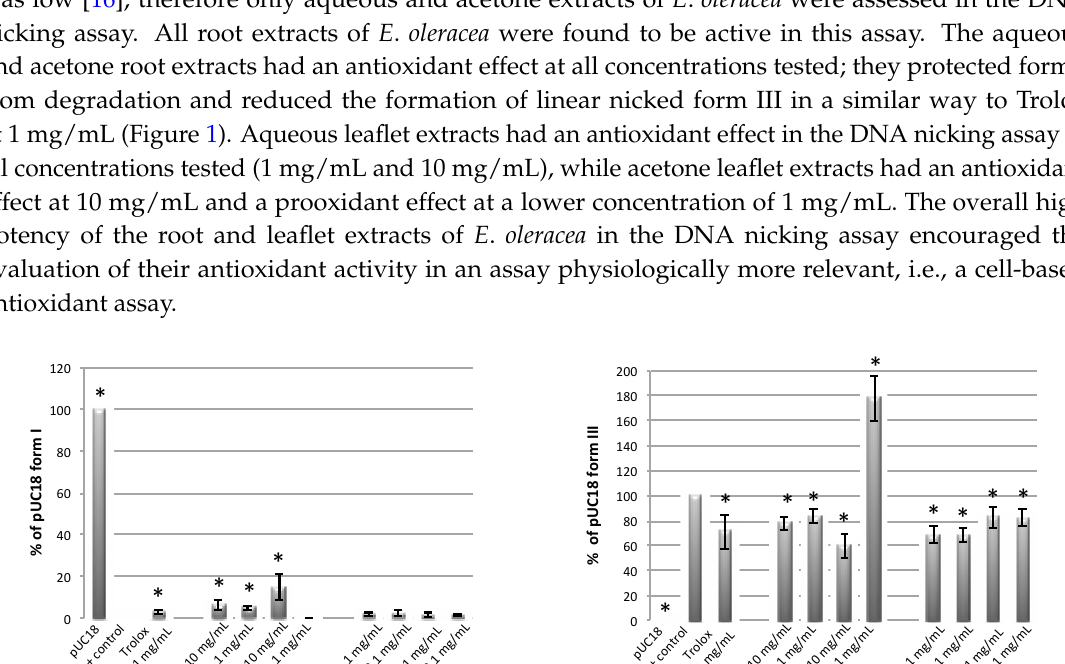
Table 1. Antioxidant activity and total phenolic content (TPC) of root and leaflet extracts of Euterpe oleracea .